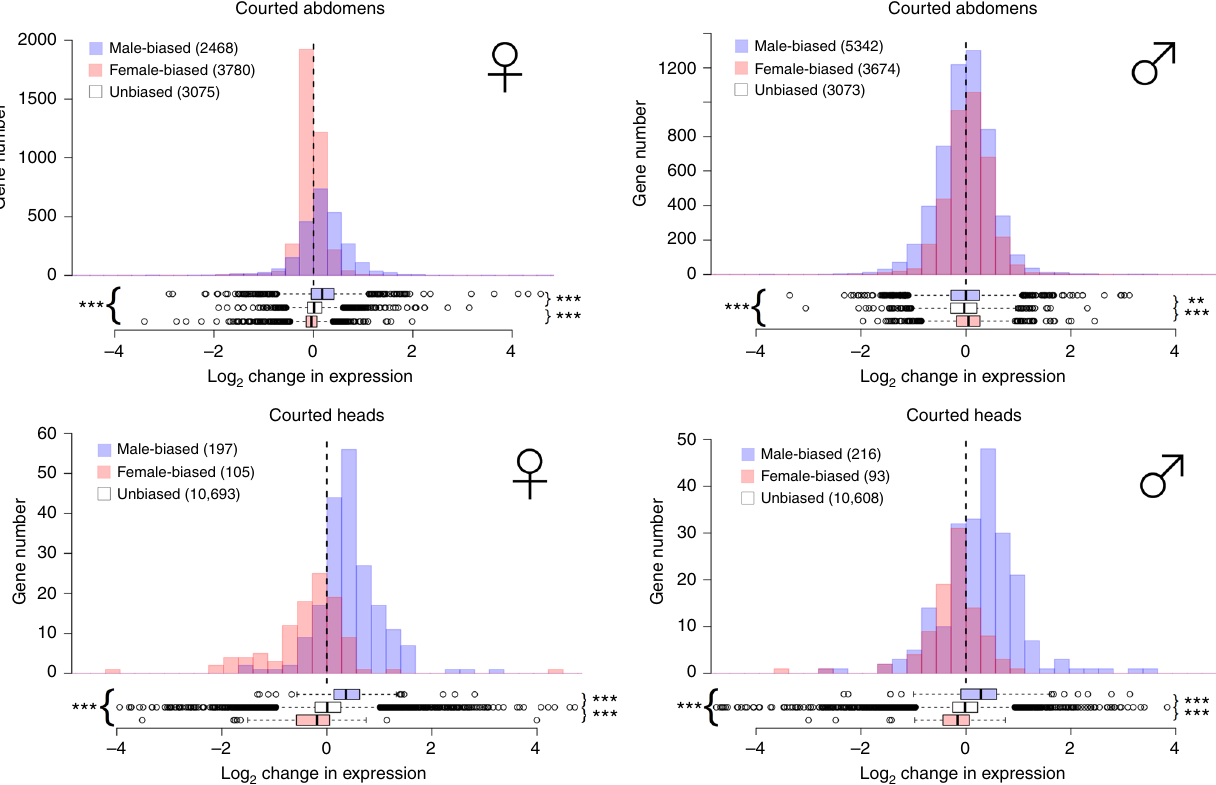
Fig. 3 Gene expression changes following mating system manipulation in courted fl ies. Positive values on the x axis correspond to high expression under Monogamy, negative values to high expression under increased Polyandry. Colours indicate male-biased (blue), female-biased (pink) and unbiased (white) genes in abdomens (top) and heads (bottom). For clarity, unbiased genes are omitted from the histogram. The signi fi cance level of Mann – Whitney rank tests on the average level of sex-biased expression is indicated by asterisks (*** < 0.001, ** < 0.01). Asterisks to the right of the box plots summarise comparisons of male-biased and female-biased genes with unbiased genes, and those to the left between male-biased and female-biased